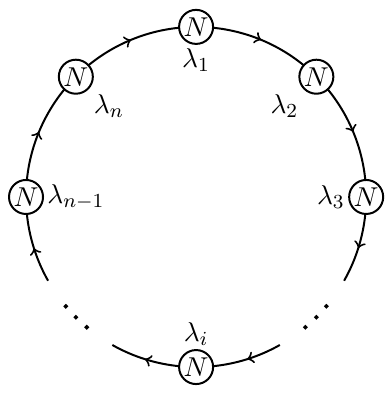
Figure 1 . n -node quiver diagram. Each node represents an SU( N ) gauge group factor and the node n + k is identified with the node k . Each arrow represents a bifundamental